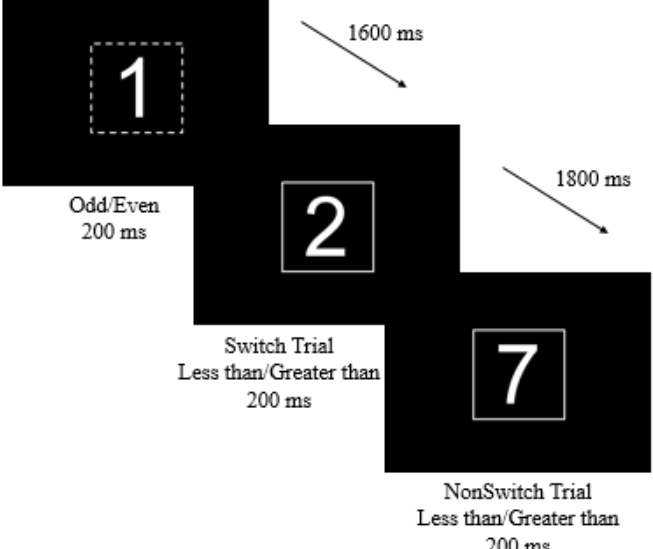
Figure 1. Task stimuli and parameters for the Switch task. Participants completed three task blocks, two homogeneous (within rule-set and dashed/solid boxes) and one heterogeneous (between rule-set and dashed/solid boxes).